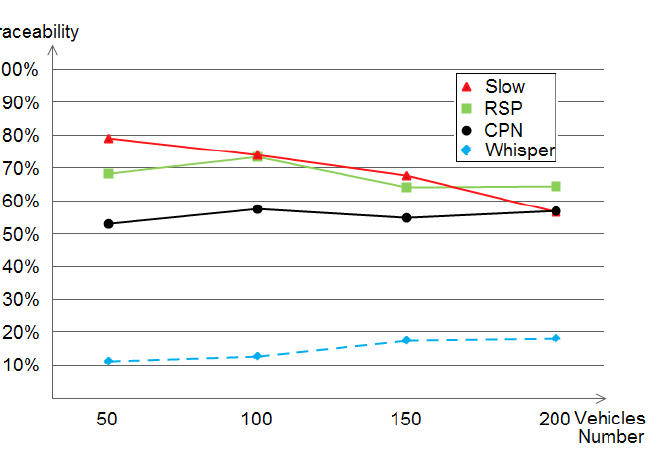
Figure 11. The achieved traceability by SLOW, Random Silent Period (RSP), Cooperative Pseudonym Change (CPN), and WHISPER within different